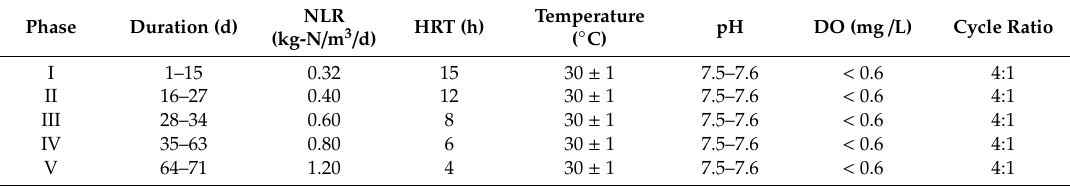
Table 3. Operating conditions of the